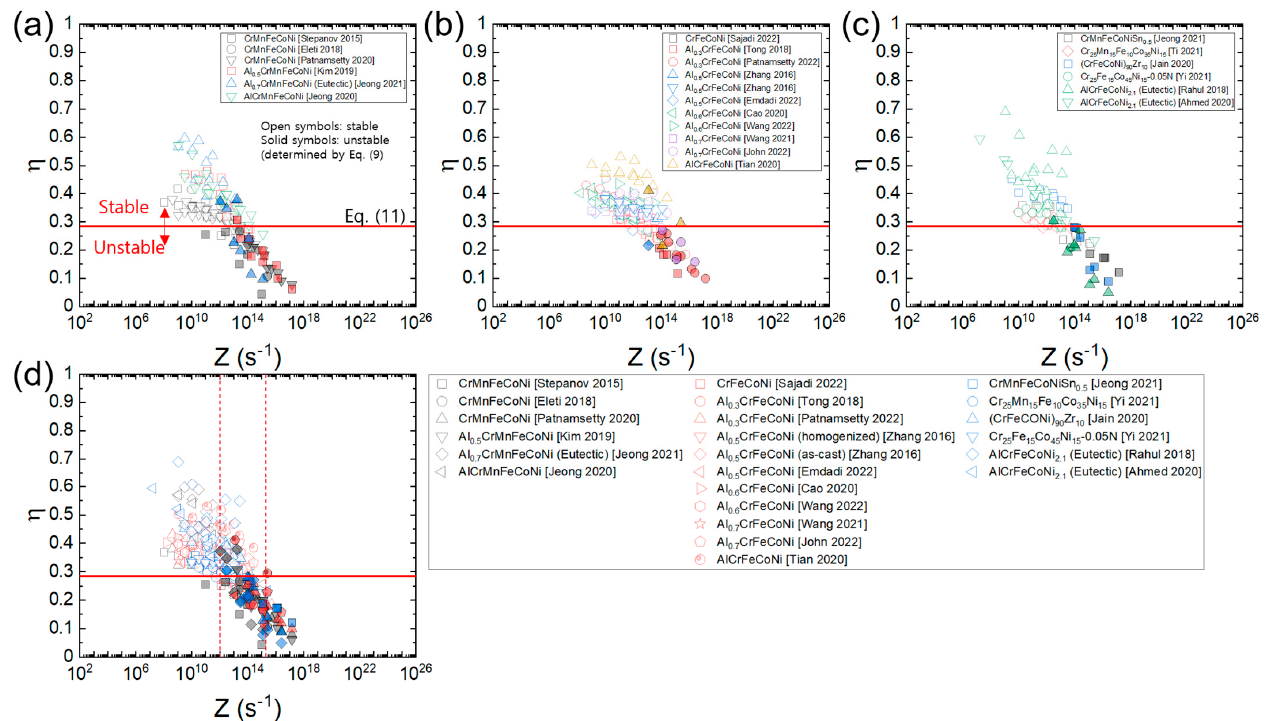
Figure 13. Plots of processing maps for ( a ) Al x CrMnFeCoNi ( x = 0–1) [9,23,34,42,45,63], ( b ) Al x CrFeCoNi ( x = 0–1) [13,25,51,53,72,84,92,96,97,100], and ( c ) CrMnFeCoNiSn 0.5 , etc. [22,47,54,60,61,64], expressed as a function of Z using the average Q c value of all the HEAs (317.2 kJ/mol) and ( d ) the plot where all the data in ( a – c ) overlap. Open and solid symbols represent the flow stability and instability conditions (determined by Equation (9)), respectively. A red horizontal line represents 𝜂 = 0.285 (Equation (11)).